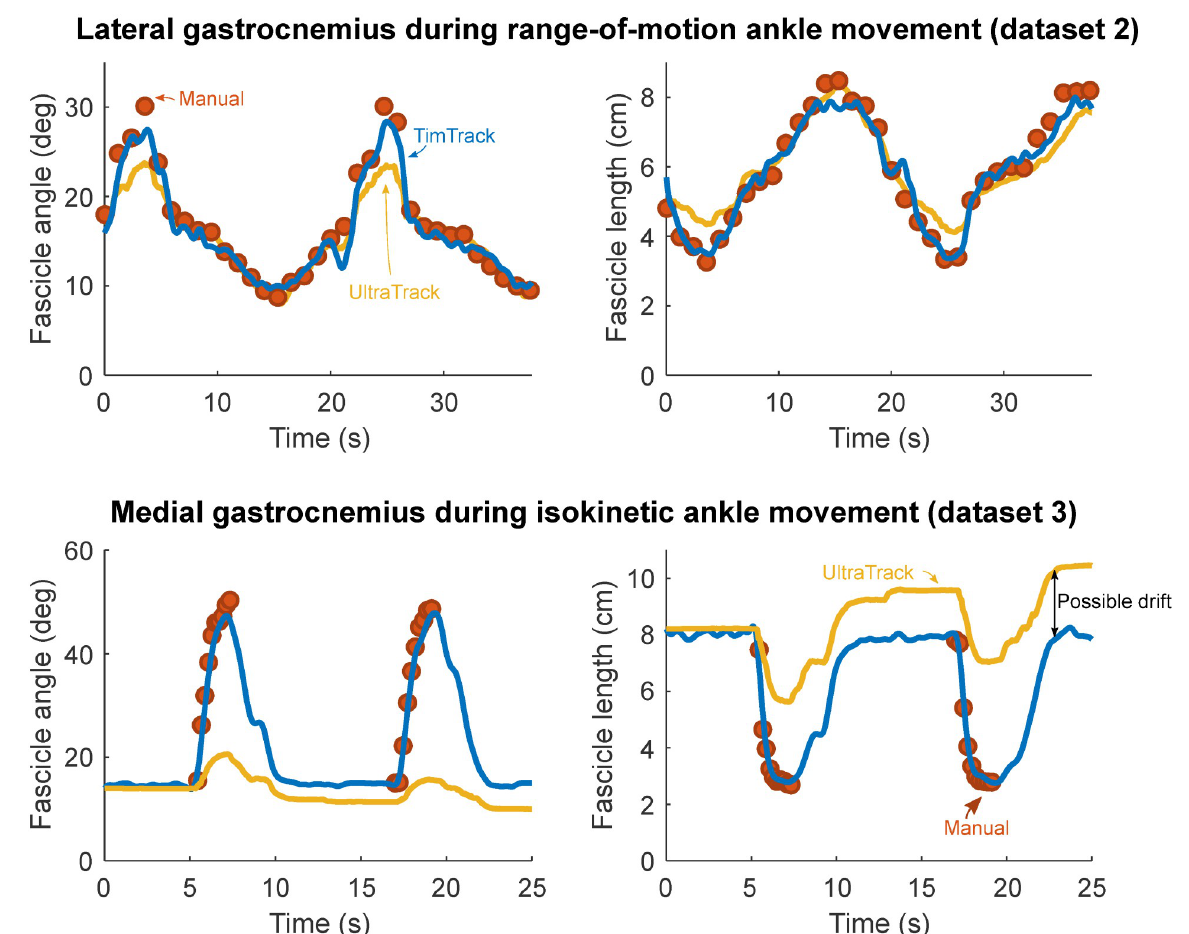
Fig 3. Fascicle angle and fascicle length estimates of TimTrack, UltraTrack and manual observers for two typical example trials. Fascicle angle and -length changed considerably during both movements, captured by manual observers (red dots), TimTrack (blue lines) and UltraTrack (yellow lines). Upper row: Two repetitions of a range-of-motion ankle movement from dataset 2. Lower row: Two repetitions of the 30 deg/s isokinetic ankle movement from dataset 3. UltraTrack overestimated fascicle length near the end of the trial, potentially due to integration drift. Manual estimation was performed on the concentric phase of each contraction, in accordance with the analysis by Drazan and colleagues [13].